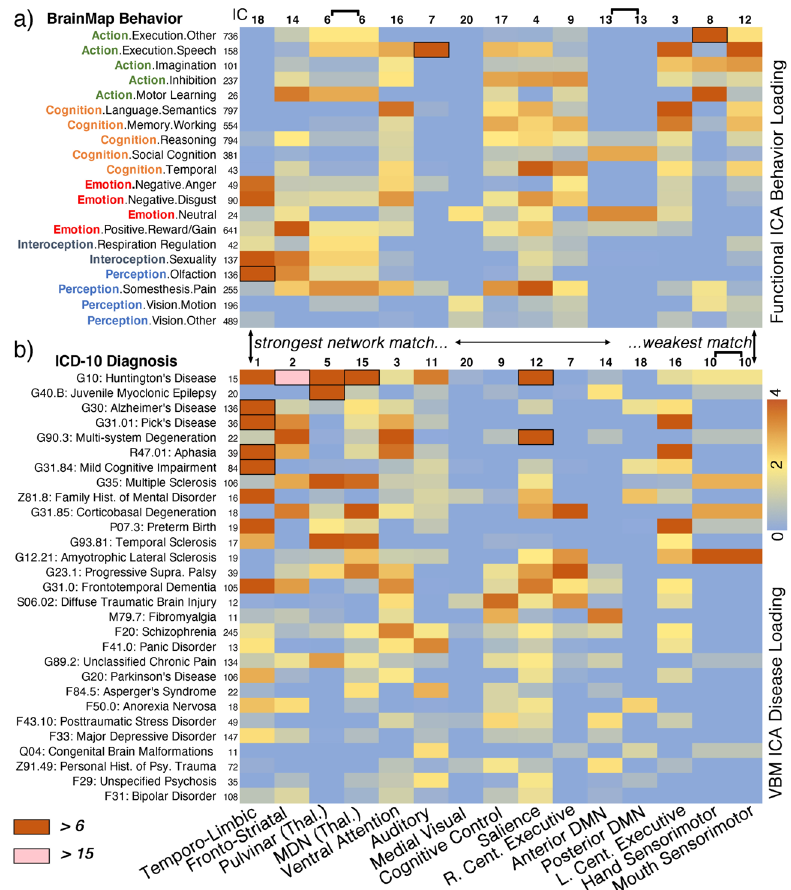
Fig. 4 Matched network metadata loadings. a Twenty (of n = 59) selected behavior domain loadings of task-activation functional networks. b Twenty- nine (of n = 43) selected disease loadings of co-alteration networks. One column, spanning panels a and b , corresponds to a network match. Stronger to weaker spatial correspondence is ordered from left to right. Metadata loadings are scaled by median absolute deviation about zero (see the “ Methods ” section). Metadata experiment volume within the database at the time of analysis are displayed to the right of the metadata label. Cell borders/shading specify more extreme loadings above 6 and 15. Source data are provided in Supplementary Data